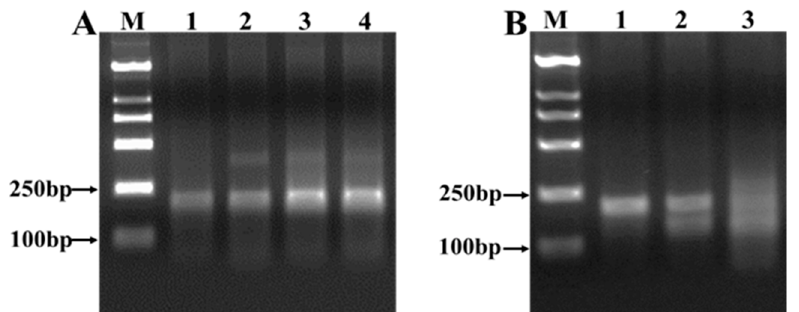
Figure 2. Optimized conditions of RPA: ( A ) Optimization of the concentration of primers. Lane M represents Marker 2000. Lanes 1–4 represent 0.1 μ mol/L, 0.15 μ mol/L, 0.2 μ mol/L, and 0.25 μ mol/L, respectively. ( B ) Optimization of the reaction temperature. Lane M represents Marker 2000. Lanes 1–3 represent 42 ◦ C, 40 ◦ C, and 38 ◦ C,